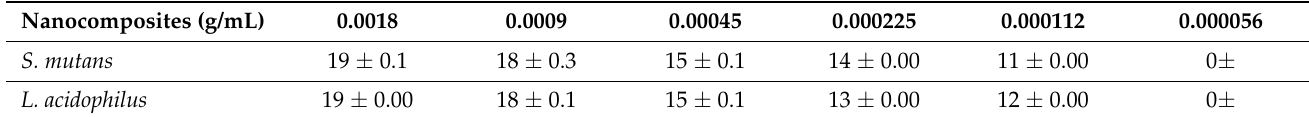
Table 4. Inhibition zone diameter (mm) of S. mutans ATCC 25175 and L. acidophilus CH-2 of Ul- Table 5. Inhibition zone (mm) of S. mutans ATCC 25175 and L. acidophilus CH-2 at different concentra- va/cellulose and Ulva/Ag/cellulose nanocomposites that were blended with fluoride. (Different tions of Ag/Ulva cellulose nanocomposites (g/mL) after 24h. letters denote significance value p < 0.05).